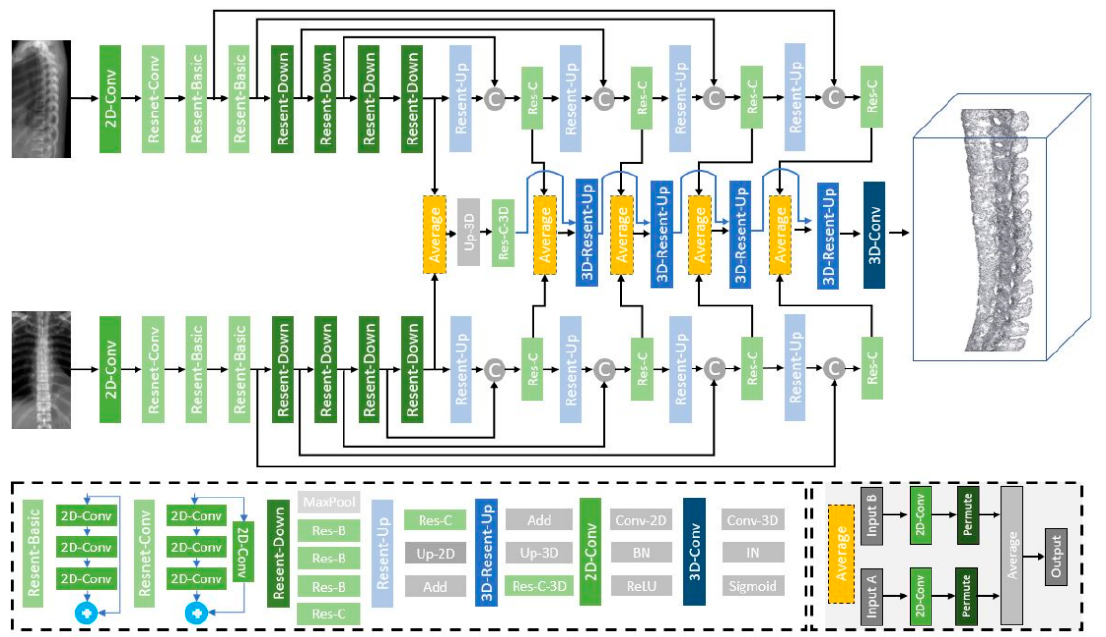
Figure 3. Generator network. The generator consisted of an encoder and a decoder (modified from X2CT-GAN generator [32]). Circle C: Concatenate; circle +: Add.